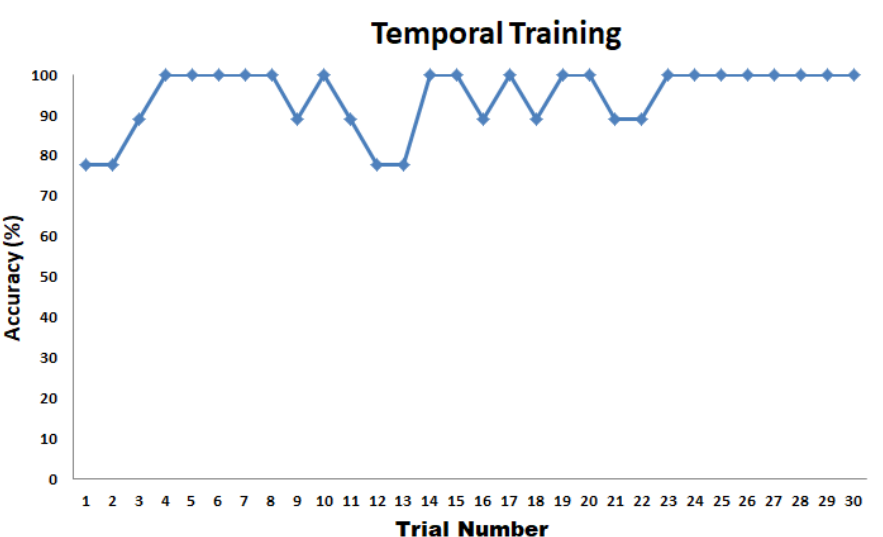
Figure 24. Temporal training